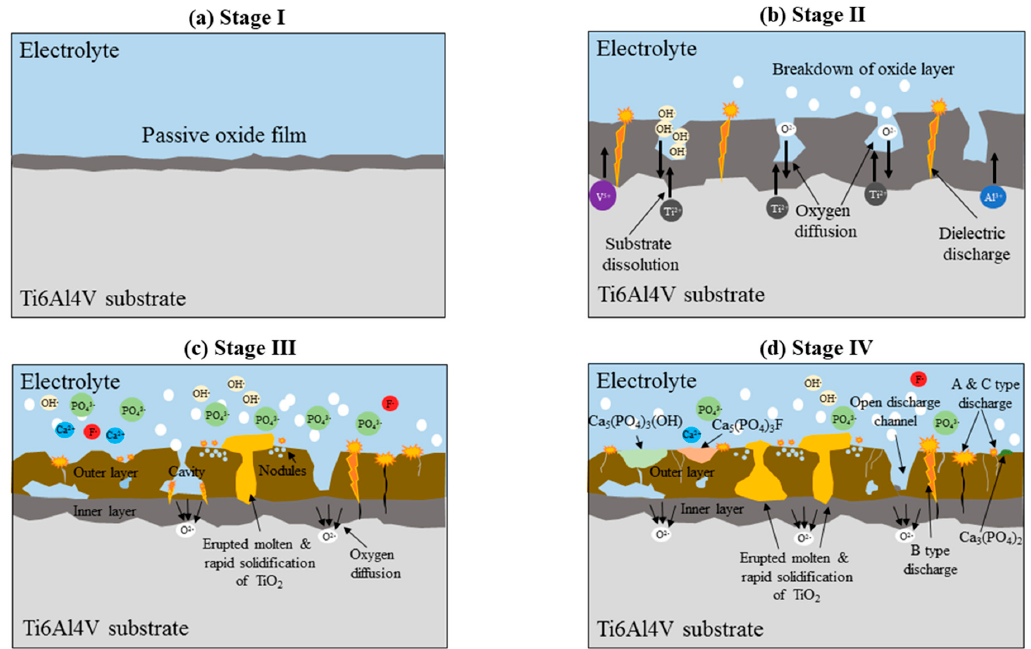
Figure 3. Schematic of the PEO process during the four different stages (adapted from [27]): ( a ) passivation of oxide film in Stage I; ( b ) breakdown of oxide layer in Stage II; ( c ) incorporation of chemical species from electrolyte into the coating layer in Stage III; and ( d ) the repetition of the process with three distinct types of plasma discharge in Stage IV.